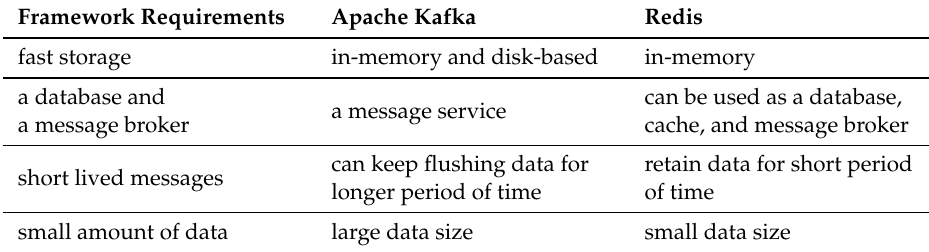
Table 1. Comparison of framework requirements to the functionalities of Apache Kafka and